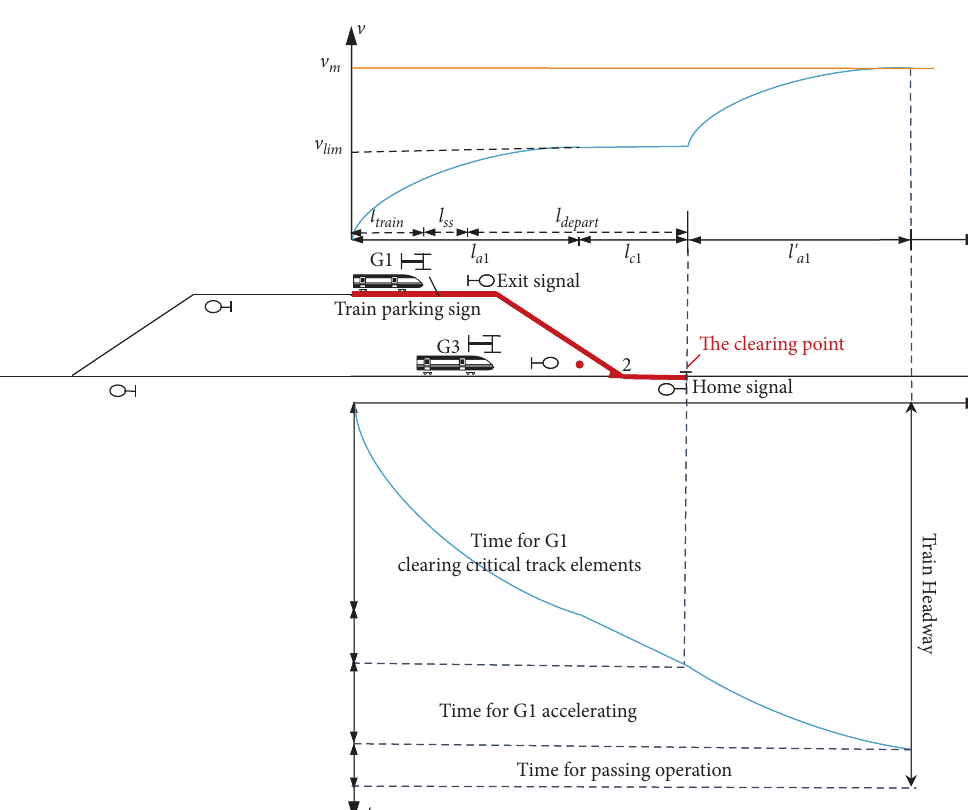
Figure 10: G1 departs and G3 passes through the